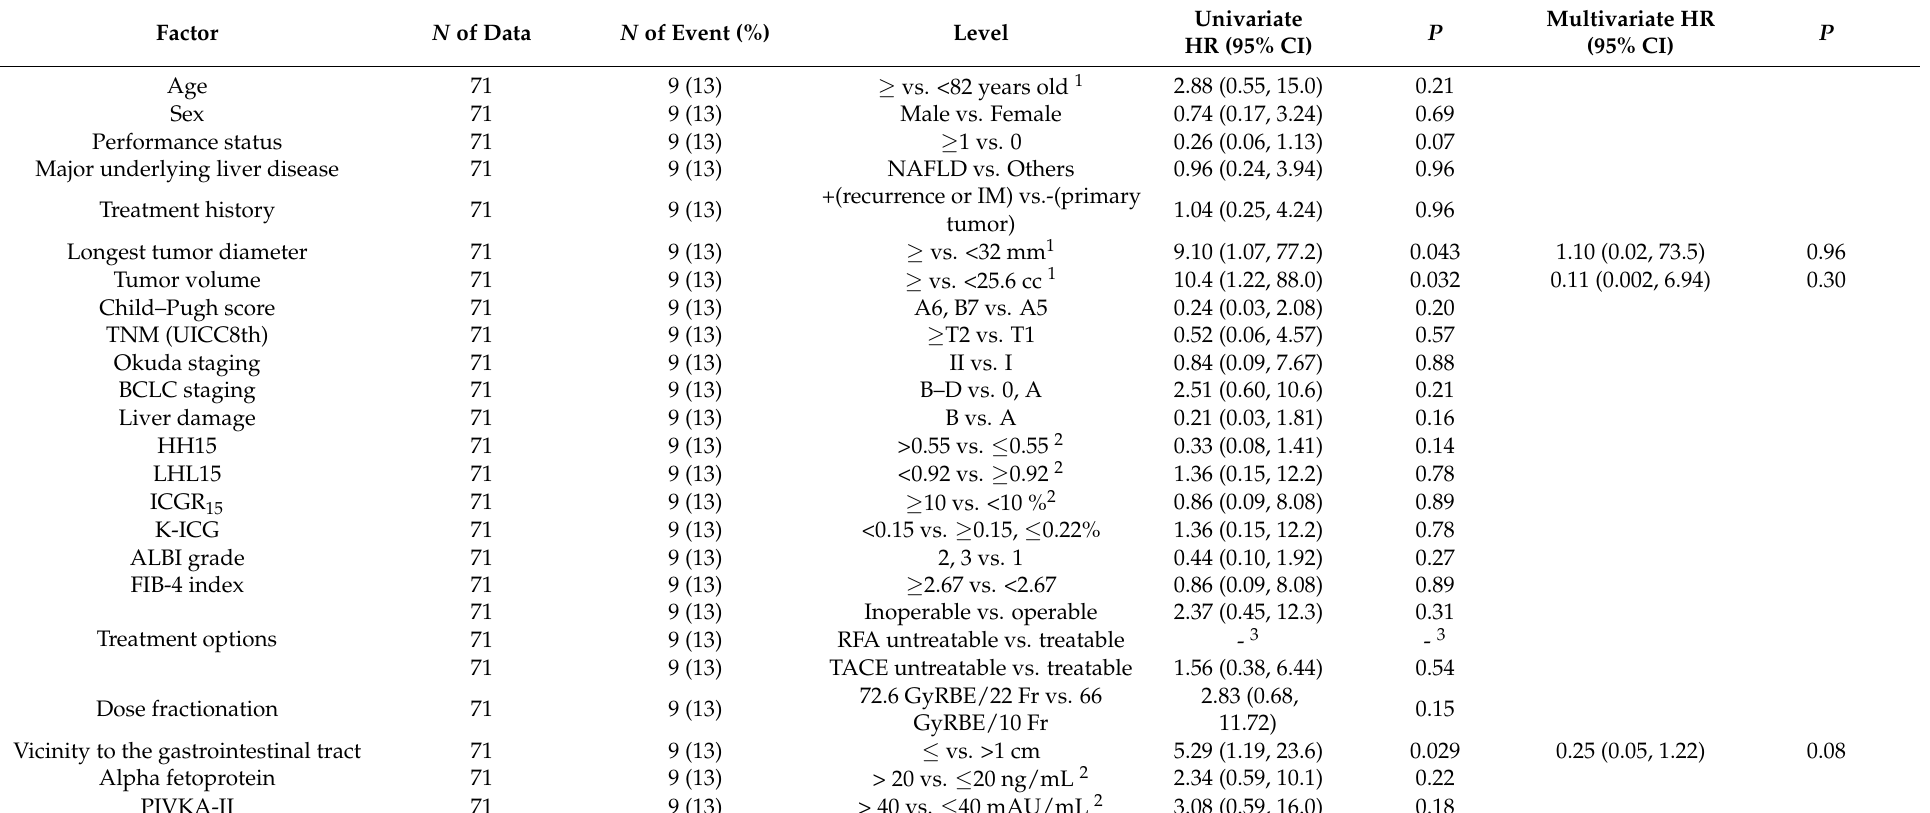
Table 4. Uni- and multivariate Cox’s analyses for local